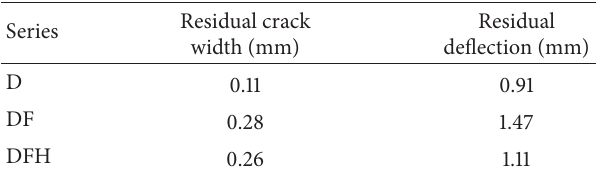
Table 2: The results of precracking